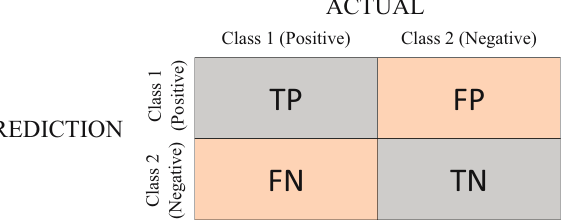
Figure 2: Confusion matrix for two classes [ 49 ]